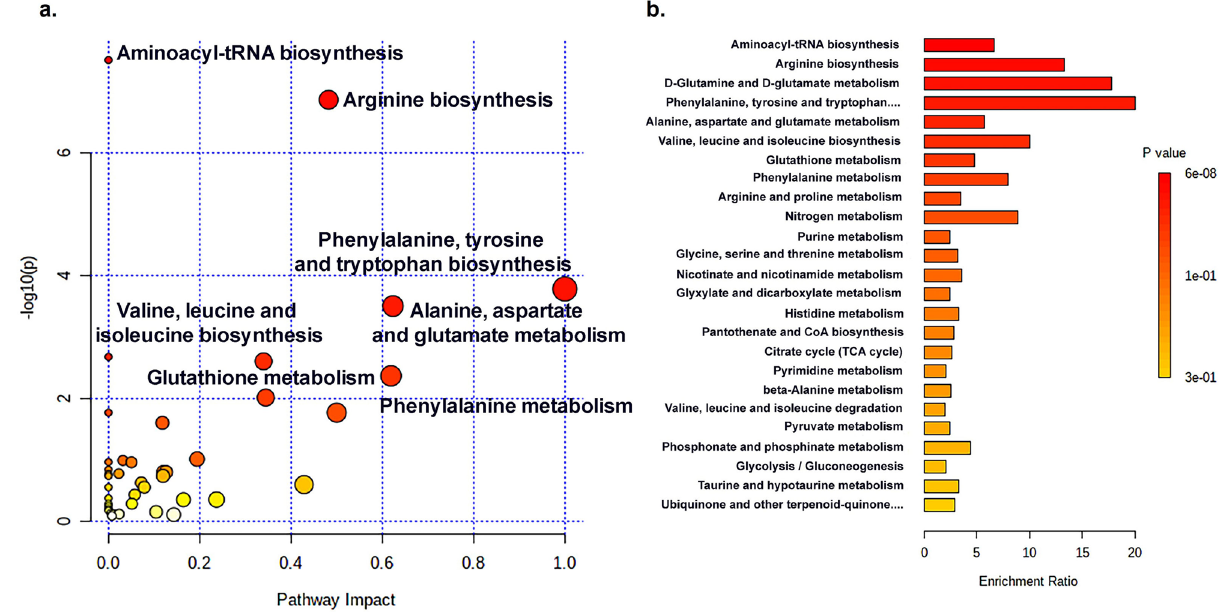
Figure 5. Summary of pathway analysis on 2D culture and 3D MCS, analyzed using MetaboAnalyst 5.0. To define the influence pathway, all metabolites in 2D culture and 3D MCS on ESI + and ESI- were elucidated by pathway analysis. ( a ). Metabolic pathway analysis on 2D culture and 3D MCS. ( b ). Enrichment analysis on identified metabolite in 2D culture and 3D MCS from CCA and cholangiocyte cell lines. The figure was generated by MetaboAnalyst 5.0 (https:// www. metab oanal yst. ca/) 21 using our experimental data as input. Pathways Hits Raw p Holm adjust FDR